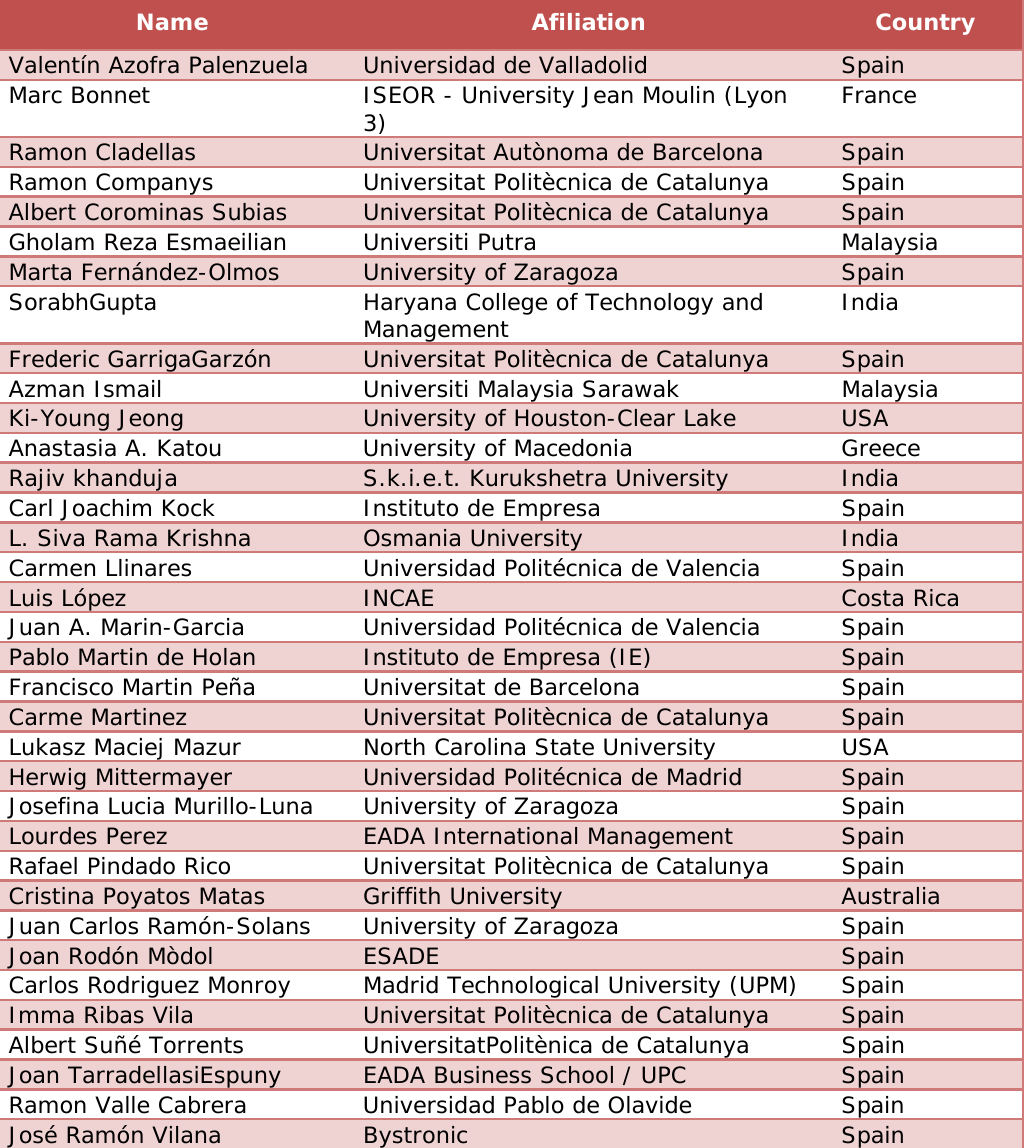
Table 2. “Reviewers who have participated in at least one review during the